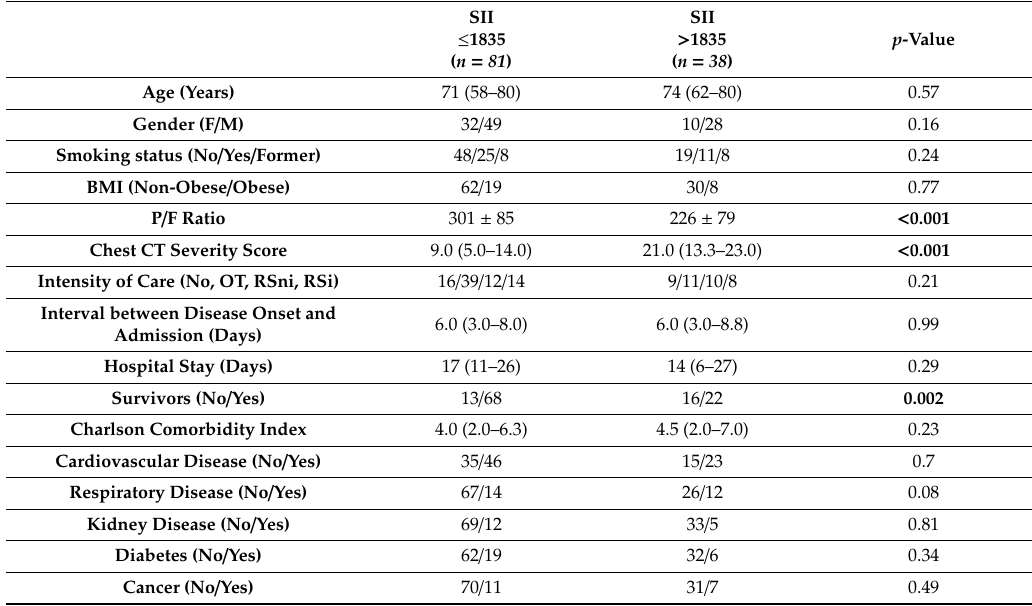
Table 5. Demographic, clinical, and laboratory characteristics of COVID-19 patients stratified by the